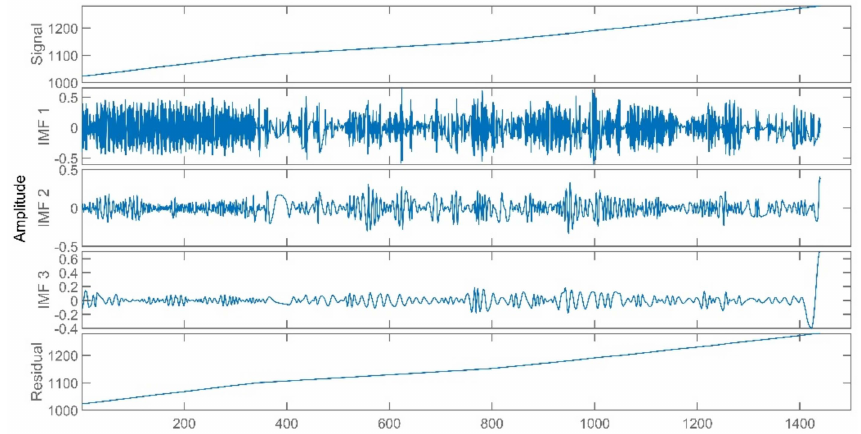
Figure 21. Drift Failure Signal of EMD.